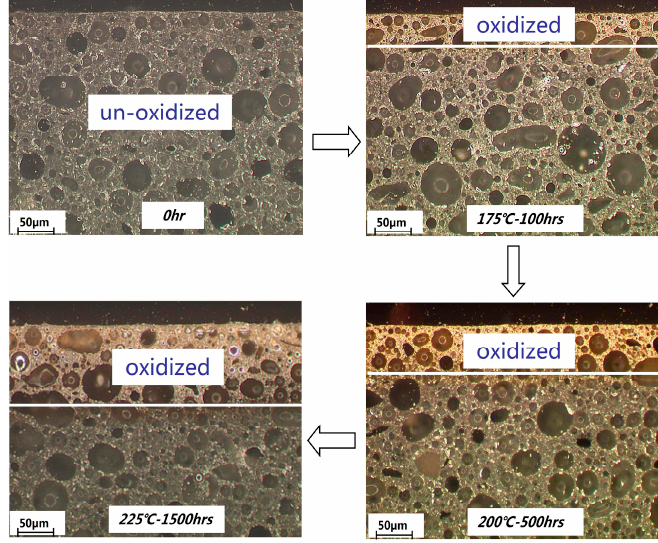
Figure 8. Microscopic images of sample 1 at different aging temperatures and times.